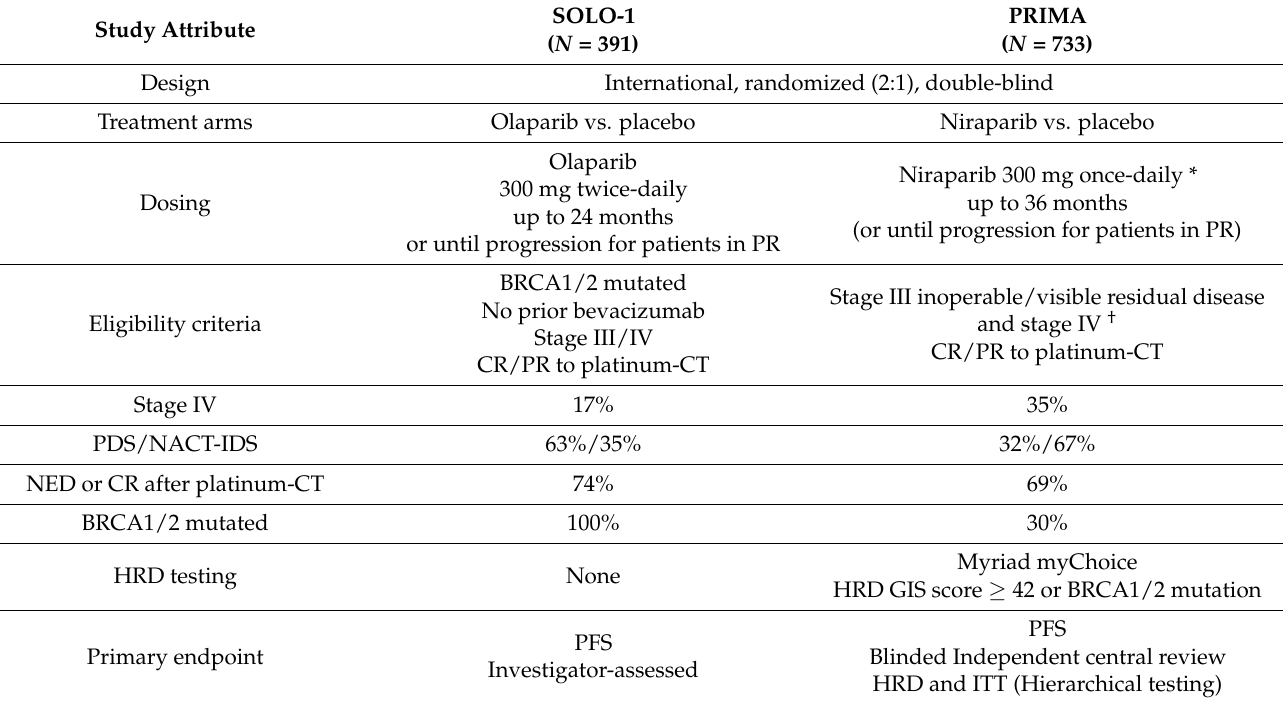
Table 3. Comparison of study design and patient characteristics in phase III trials of olaparib and niraparib maintenance monotherapy in the first-line